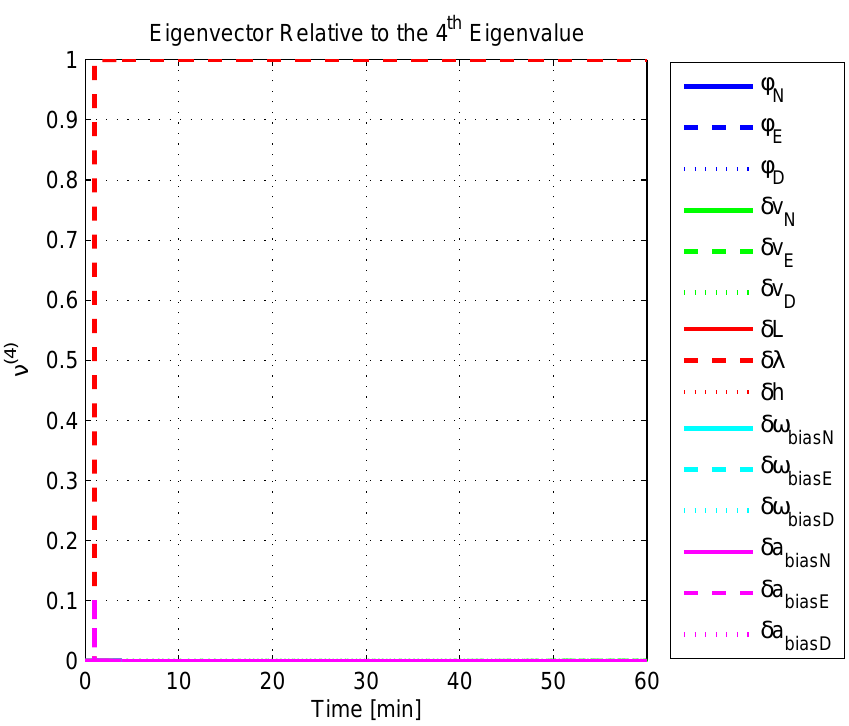
Figure 11. Eigenvector relative to the fourth eigenvalue in the simulated